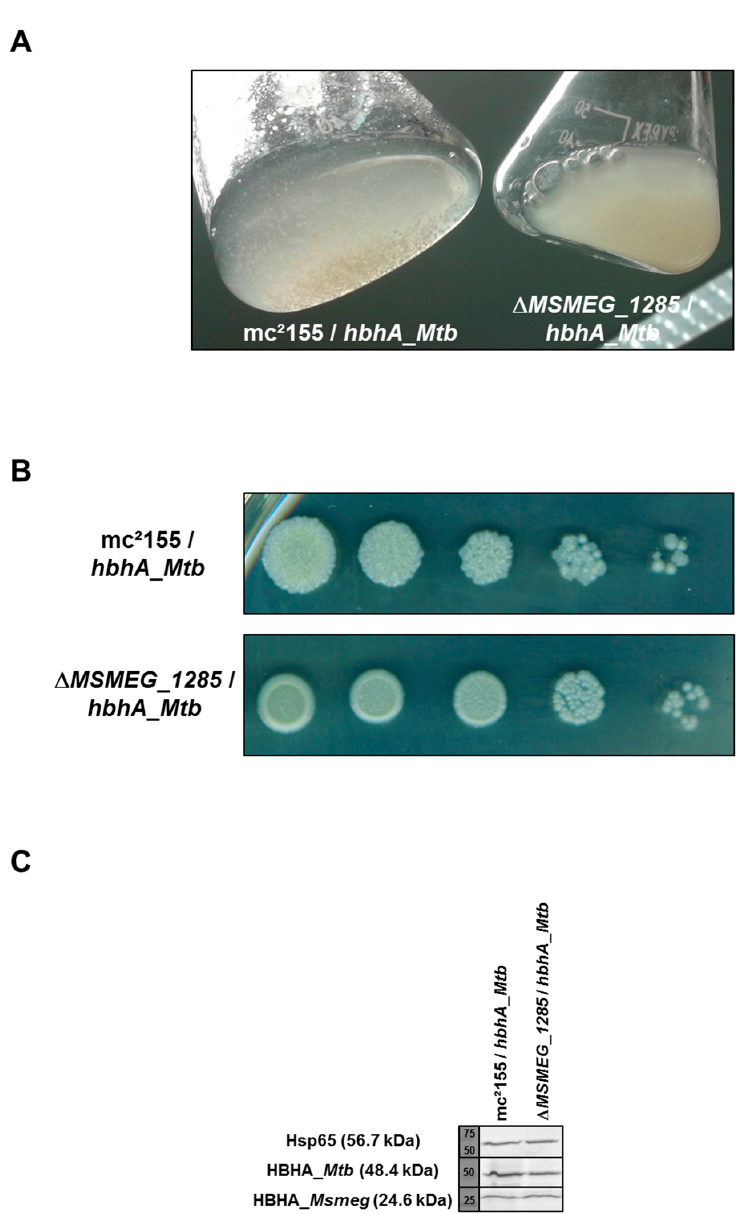
Figure 4. Heterologous expression of hbhA_Mtb in the Δ MSMEG_1285 mutant affects auto-aggregation and colony morphology. ( A ) Overnight cultures in 7H9 supplemented with OADC and without detergent of Msmeg mc 2 155 and the Δ MSMEG_1285 mutant, both expressing hbhA_Mtb ; ( B ) Serial dilution of Msmeg mc 2 155 (upper series) and the Δ MSMEG_1285 mutant (lower series), both expressing hbhA_Mtb , on 7H11 agar plates; ( C ) Western-blot analysis using monoclonal antibodies anti-Hsp65 (upper panel), anti-HBHA VF2 (medium panel) and anti-HBHA D2 (lower panel) on 40 µg of total lysates from Msmeg mc 2 155 and the Δ MSMEG_1285 mutant, both expressing hbhA_Mtb . 2.6. MSMEG_1285 Is Necessary for Full Infectivity of Msmeg mc 2 155 Expressing hbhA_Mtb